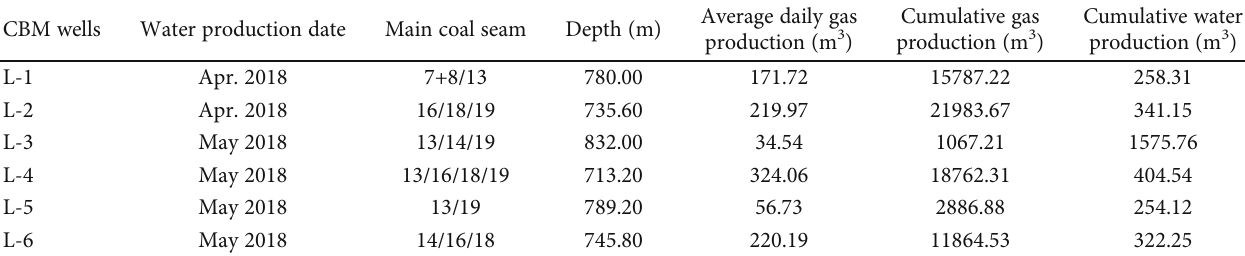
Table 1: Characteristics of production